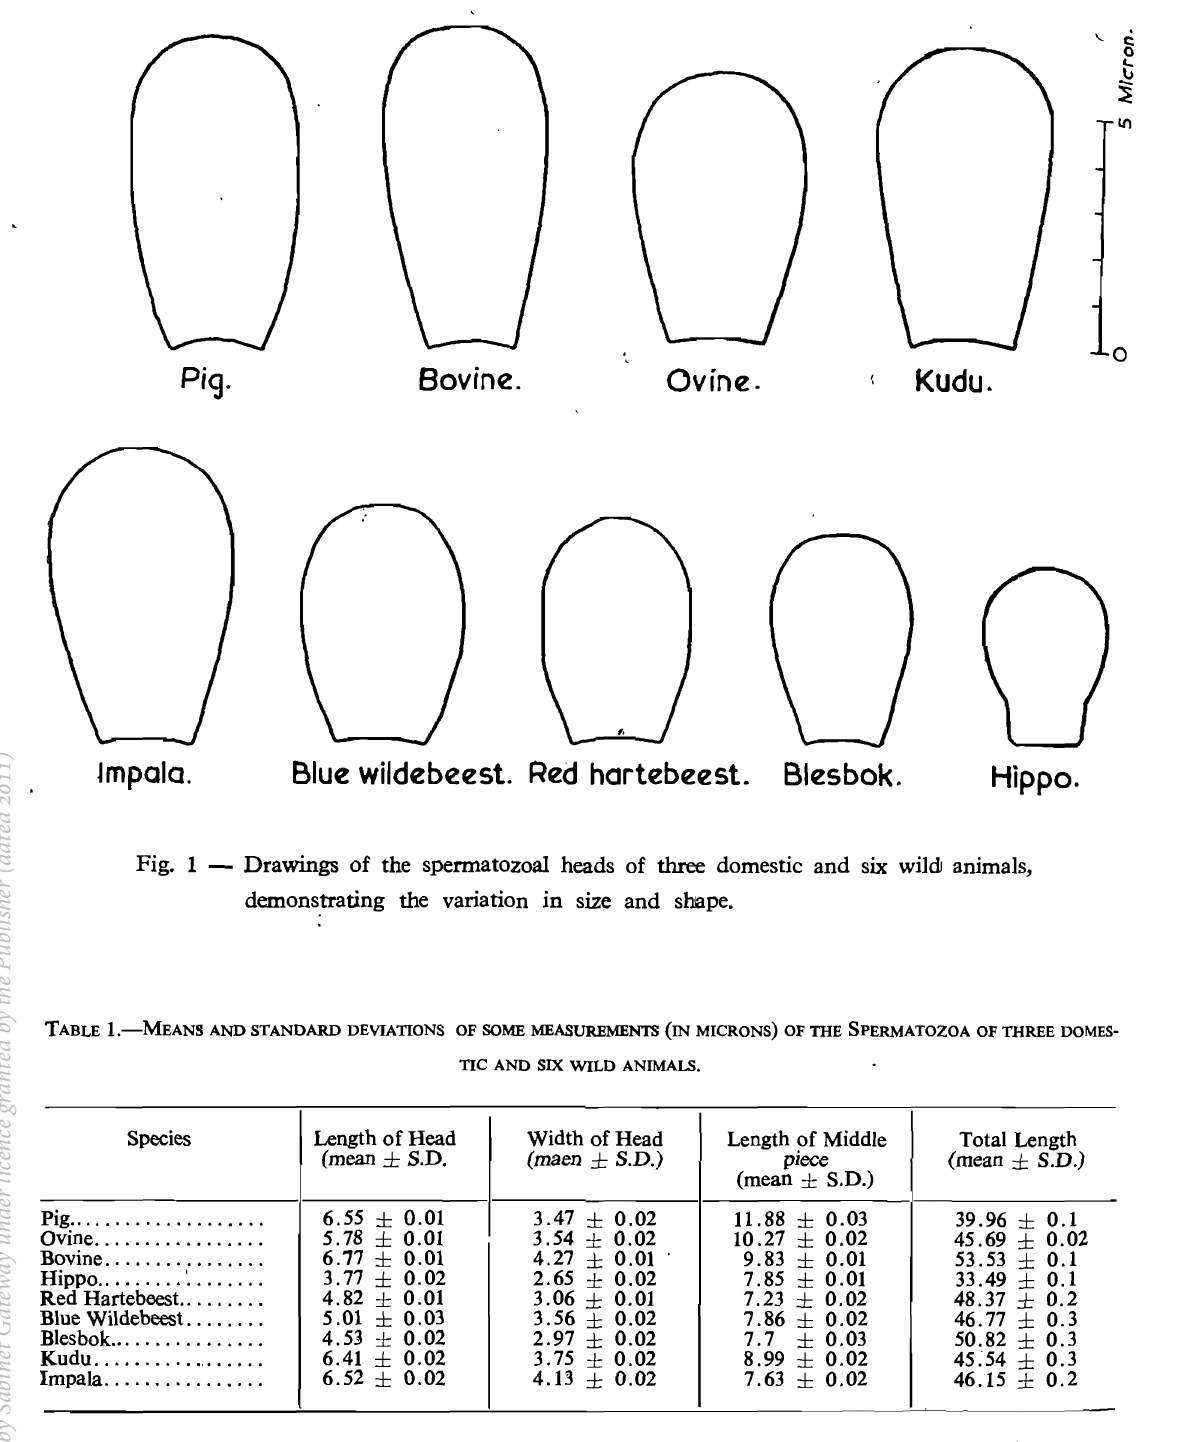
TIC AND SIX WILD ANIMALS.